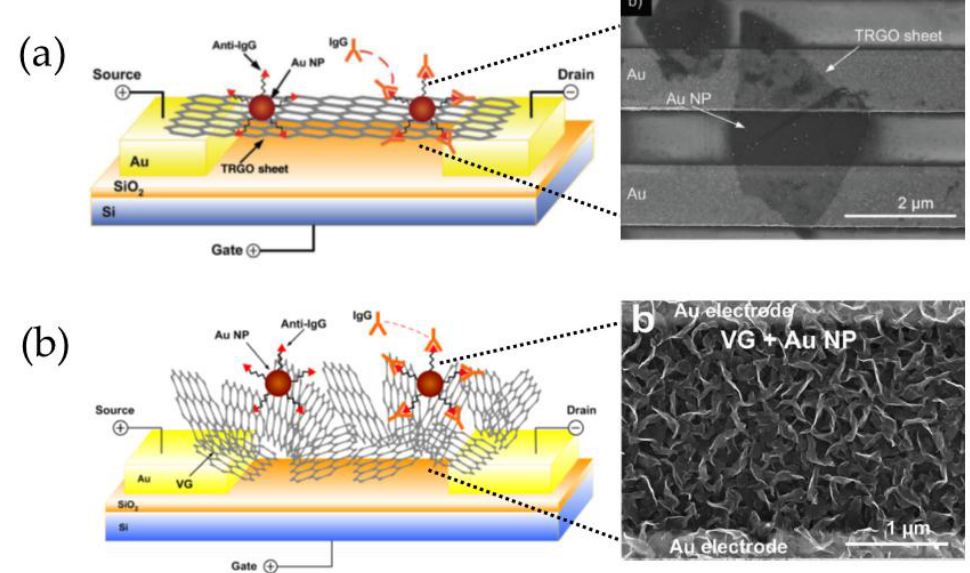
Figure 6. Representative schemes of FET immunosensors based on hybrid nanomaterials combined with corresponding SEM images of nanohybrids proposed by Mao and co-workers in different reports: ( a ) reduced graphene oxide decorated with gold nanoparticles-antibody conjugates [126]; and ( b ) vertically-oriented graphene sheets functionalized with gold nanoparticles conjugated with antibodies [127].